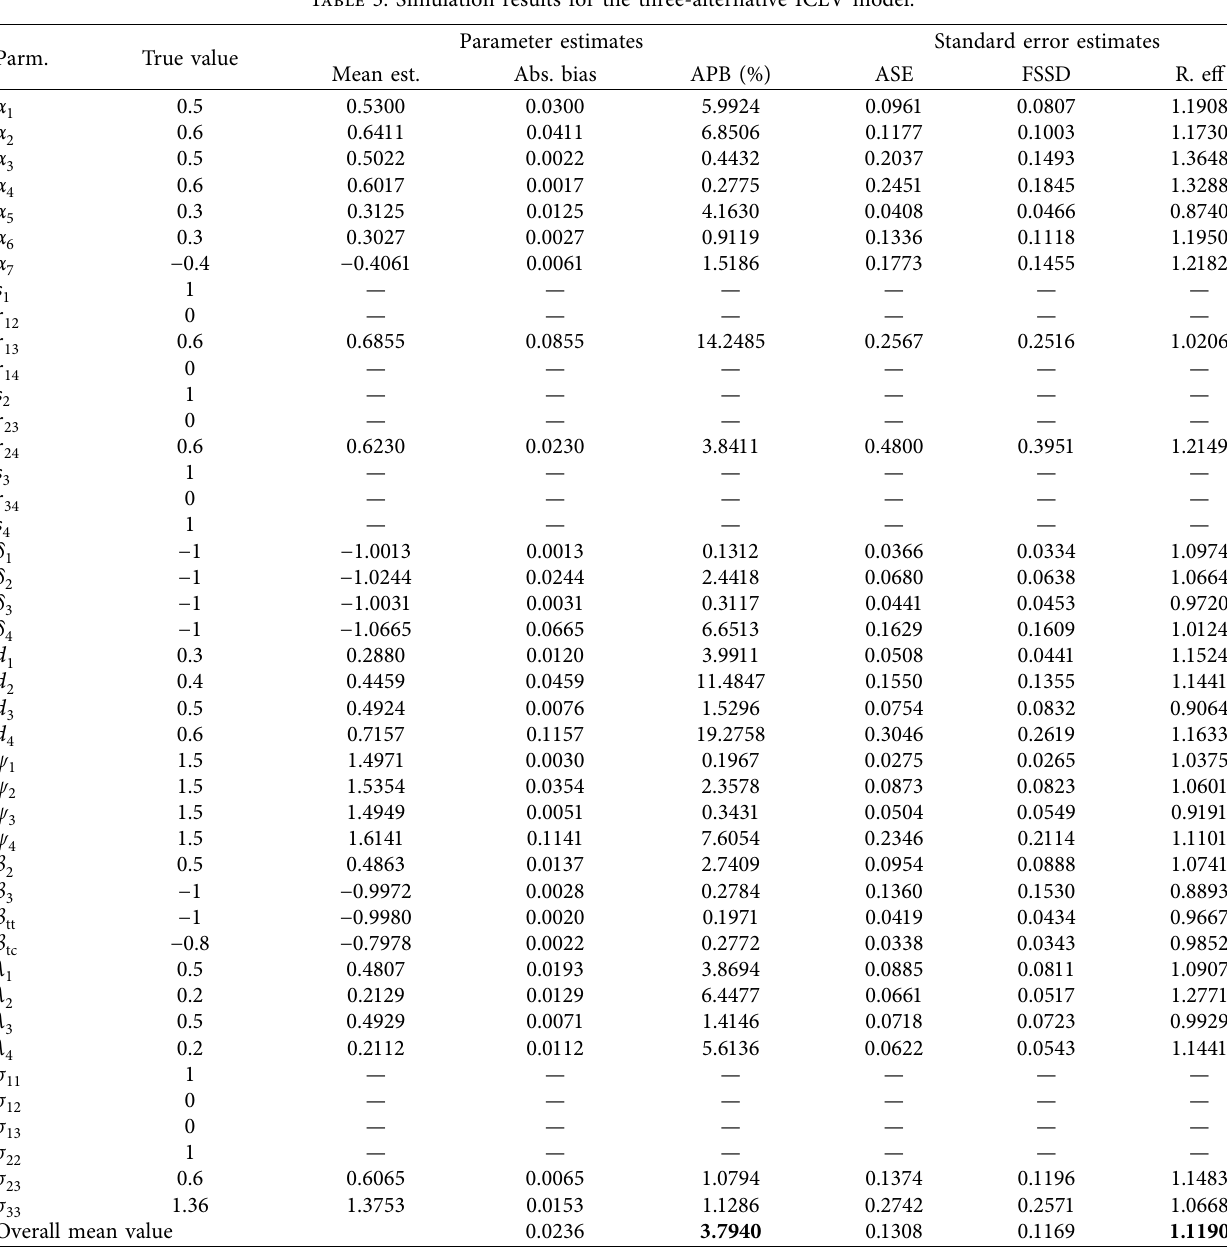
Table 3: Simulation results for the three-alternative ICLV model.